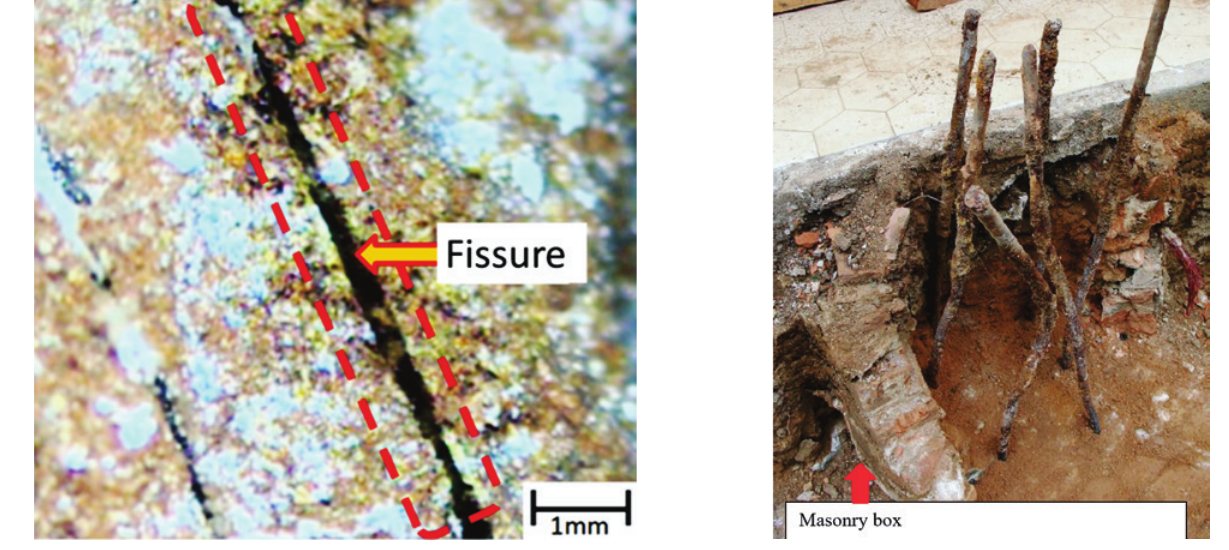
Fissure observed on the surface of one of the foundation block protruding reinforcing